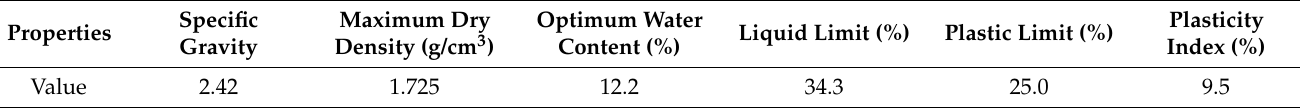
Table 1. Basic physical properties of soil